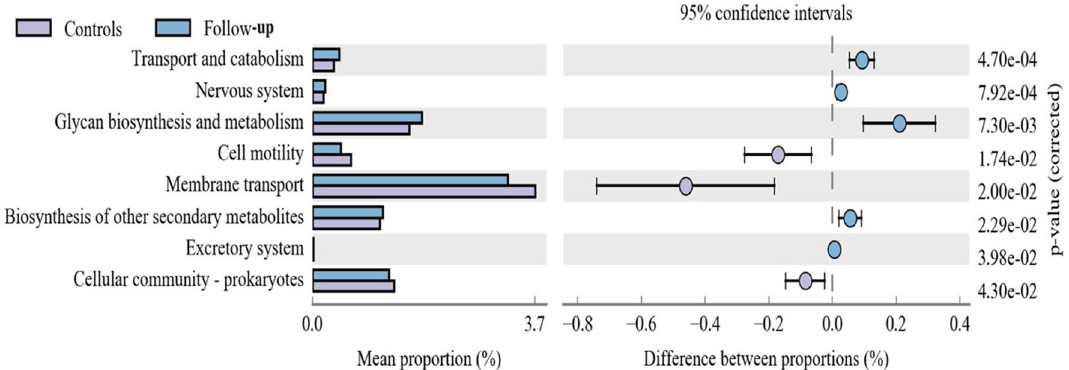
Figure 5. Metabolic pathway analysis between Controls group and Follow-up group. The left side of the figure shows the abundance ratio between the two groups. The middle section shows the proportional variation in functional abundance within the 95% confidence interval. The p value is on the